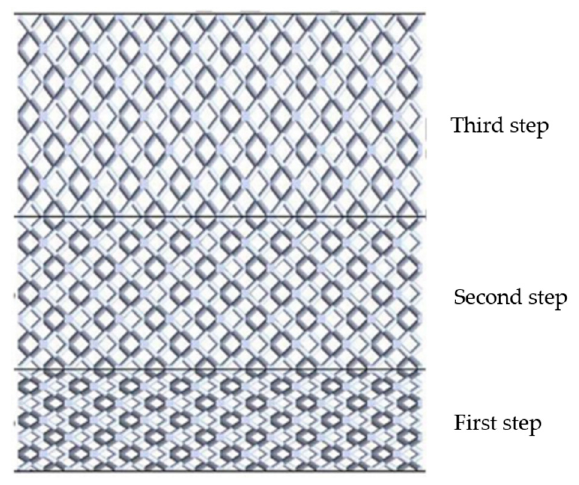
Figure 3. Gradient lattice structures [76].